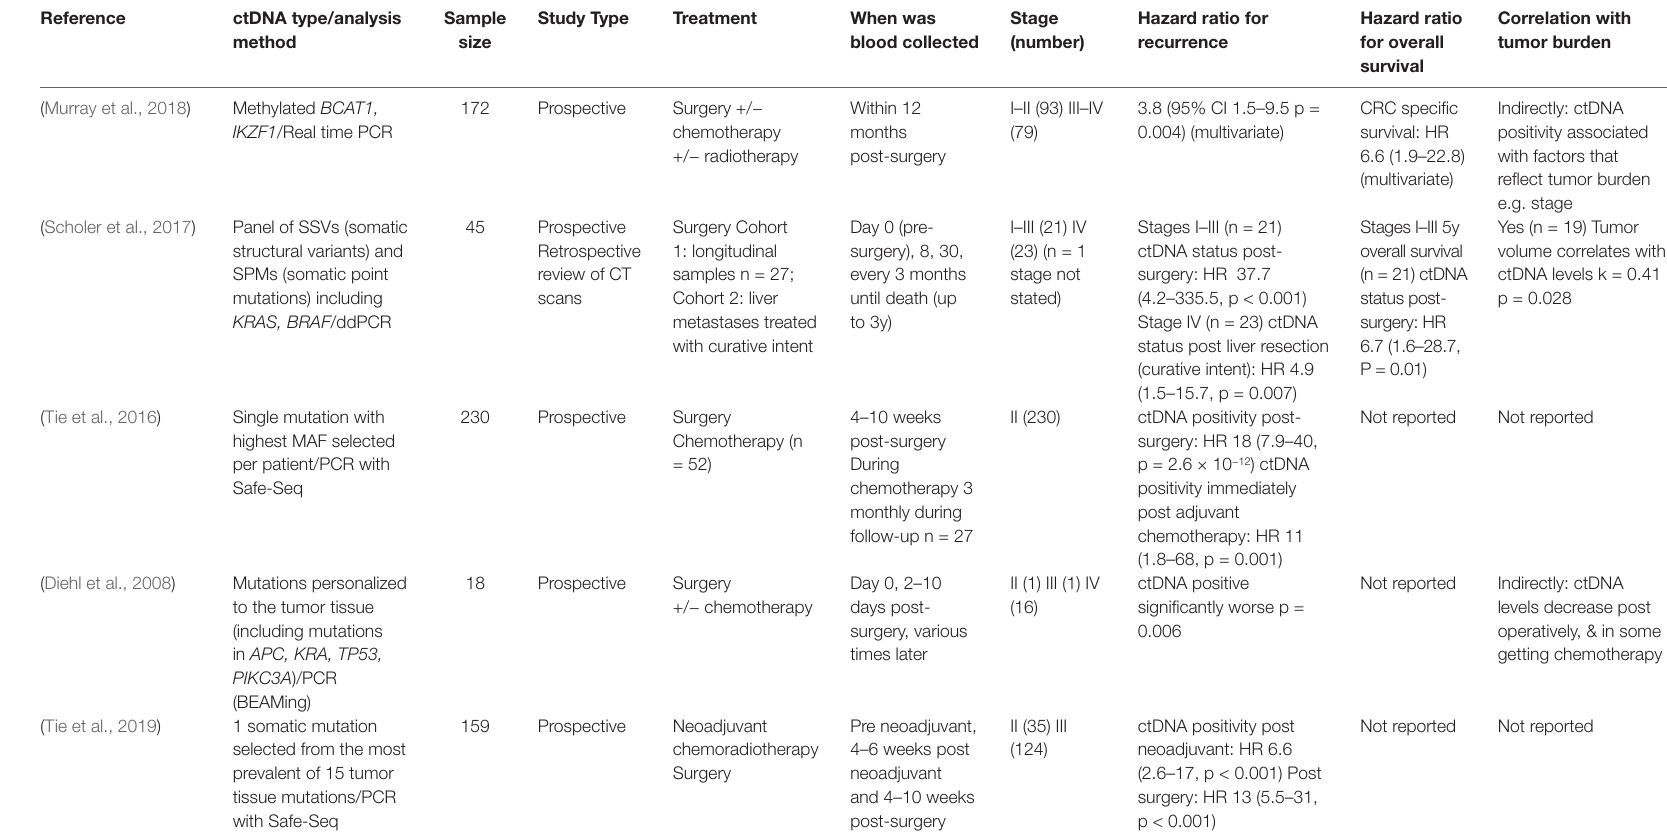
TABLe 1 | Studies assessing circulating tumor DNA (ctDNA) levels after surgery (all hazard ratios are calculated comparing those who were ctDNA positive with those who were ctDNA